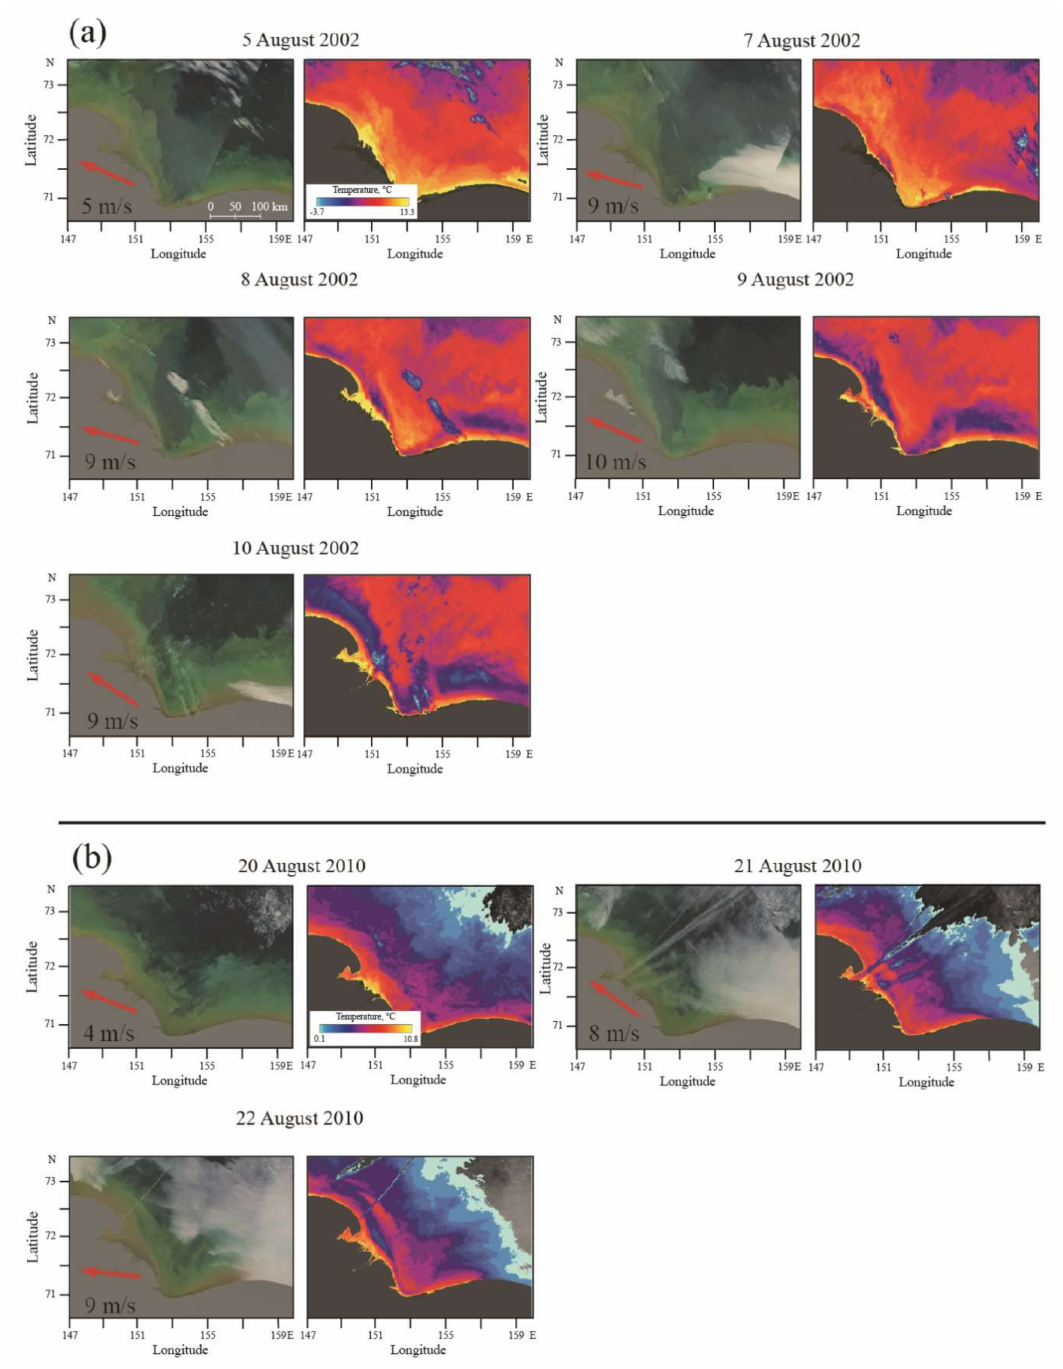
Figure 9. Corrected reflectance (left) and brightness temperature (right) from MODIS Terra and MODIS Aqua satellite images of the area adjacent to the Indigirka Delta acquired on ( a ) 5, 7–10 August 2002 and ( b ) 20–22 August 2010 illustrating formation of the upwelling event in response to wind forcing